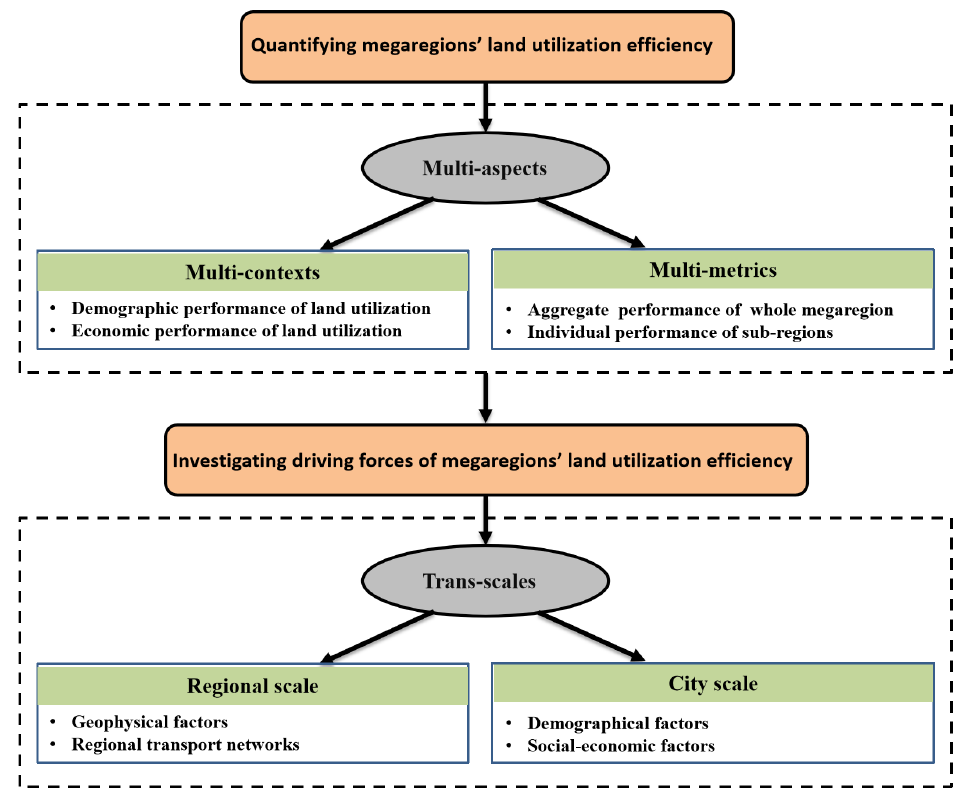
Figure 2. Framework for assessing the land use performance of large urban agglomerations.